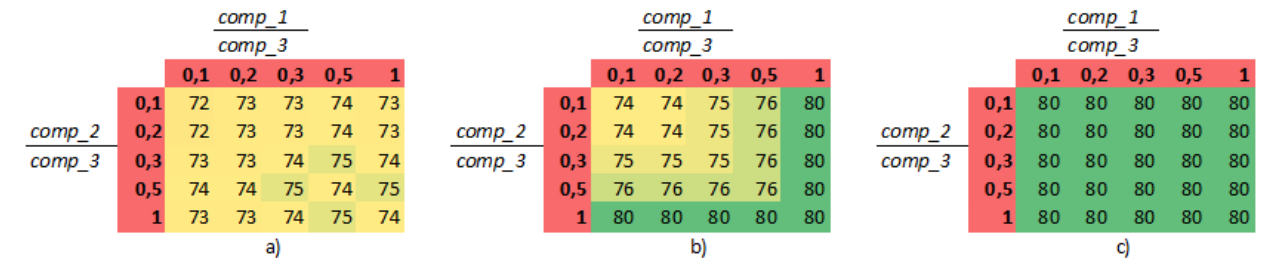
Figure 4. Results of WCET in three threads and four iteration loops situation, obtained by ( a ) brute-force modeled WCET ( b ) proposed WCET model, and ( c ) theoretical WCET model.